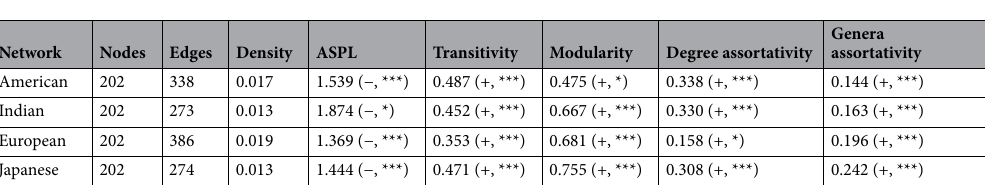
Table 1. Cohort network topological properties. Network topological properties calculated for each cohort’s network. The plus (+) or minus (−) sign indicates that the network property was greater or lower than the average of 1000 random networks. Stars indicate that the network property was statistically significantly different (P-value: * < 0.05, ** < 0.01, *** < 0.001) based on the Monte Carlo simulations.